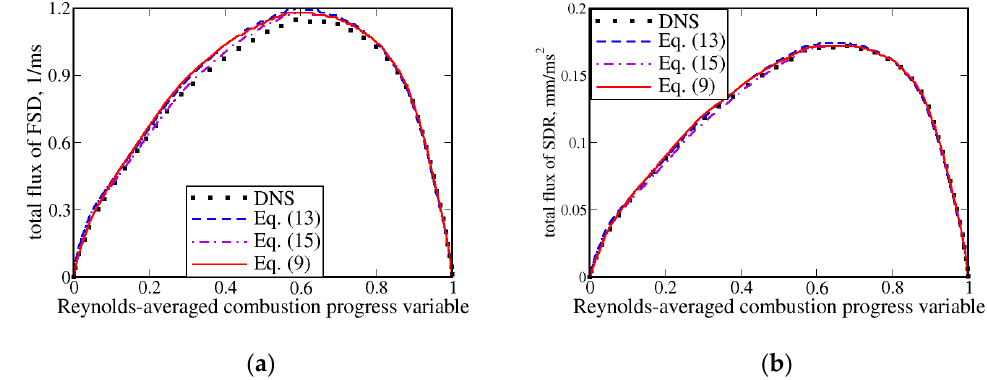
Figure 3. Total axial fluxes of ( a ) FSD Σ and ( b ) SDR χ . Case L.